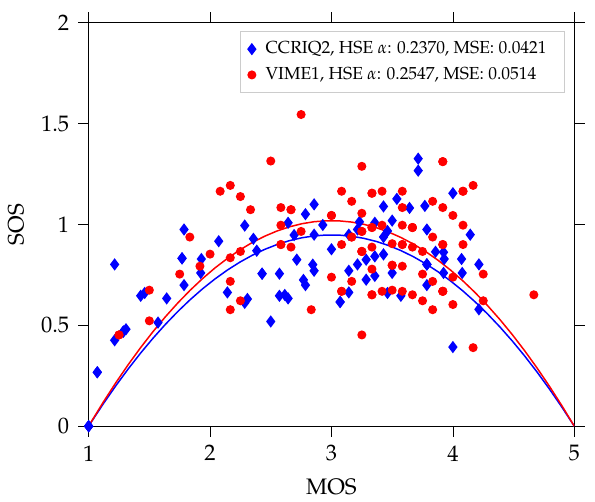
Figure 3. A comparison of HSE α parameters between the VIME1 and CCRIQ2 data sets. We use the α parameters to fit the quadratic function proposed in [26]. It models the dependency between mean opinion scores (MOS) and standard deviation of opinion scores (SOS). We analyze both data sets without unreliable subjects (screened according to [30] with the threshold correlation set to